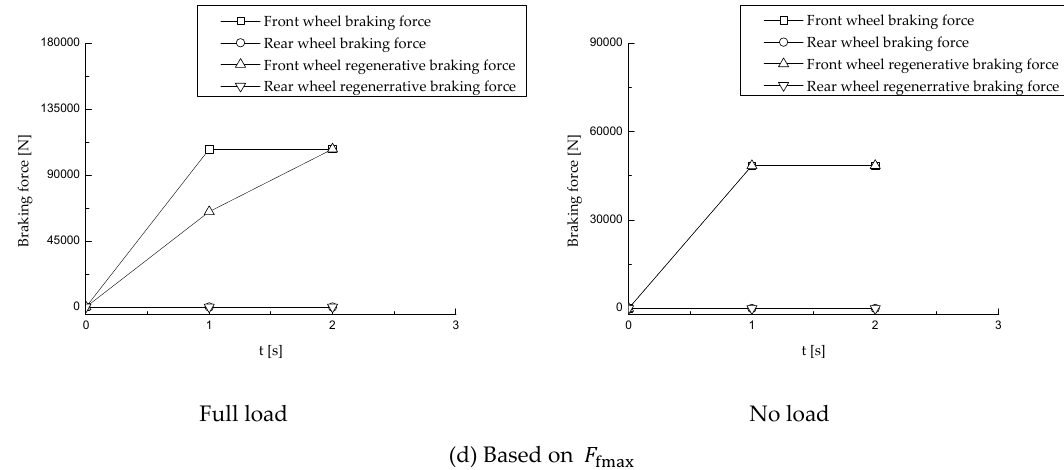
Figure 11. Different strategy braking force distribution at full load and no load. ( a ) Based on vehicle speed; ( b ) based on I curve; ( c ) based on β line; ( d ) based on F fmax .